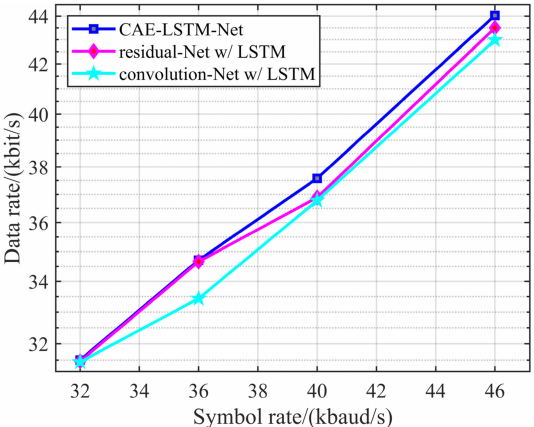
Figure 16. Data rate comparison by using different CNN-based